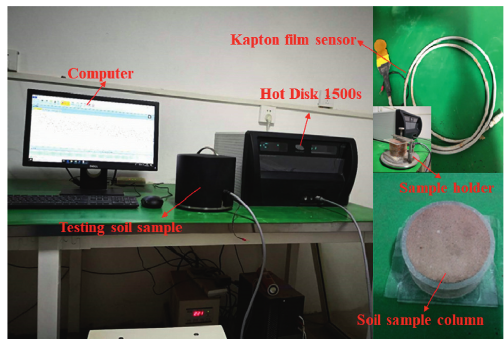
Figure 4: Thermal conductivity test